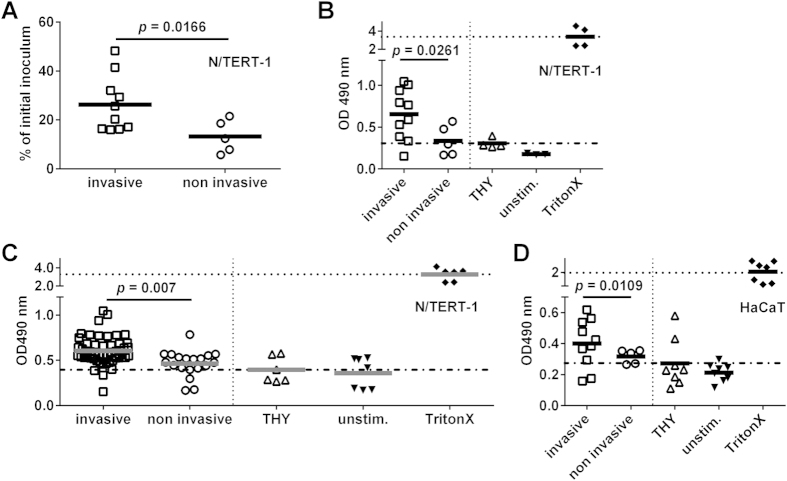
SDSE induced cytotoxicity towards human keratinocytes.(A) Total bacterial counts (selected cohort) recovered from N/TERT-1 cells 2 hours post infection and cytotoxicity towards these cells (B). (C) Cytotoxicity induced by bacterial supernatants from entire cohort on eukaryotic N/TERT-1 cells. (D) Cytotoxicity induced by bacterial supernatants from selected cohort on eukaryotic HaCaT cells. Each dot represents the mean vallue of three independent experiments with one strain. The horizontal lines within each group represent the mean value. The statistical significance between the two groups was determined using two-tailed Mann-Whitney U-test.